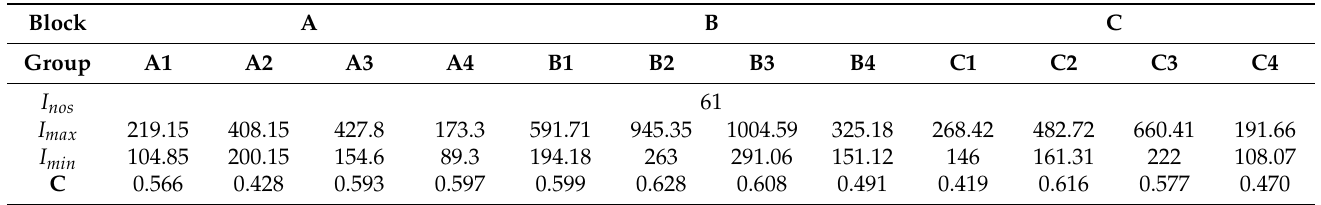
Figure 8. Streak image (left) and intensity curve (right): The purple curves in the right figure are the distributions of the average values of intensity along the horizontal direction of the selected part in the red boxes in the left image, where the abscissa are the pixel positions, and the ordinate is the intensity value. The red numbers represent the strength values of the positions shown in the red circle. Table 2. Intensity peaks, valleys and contrasts corresponding to areas A, B, and C in the image.